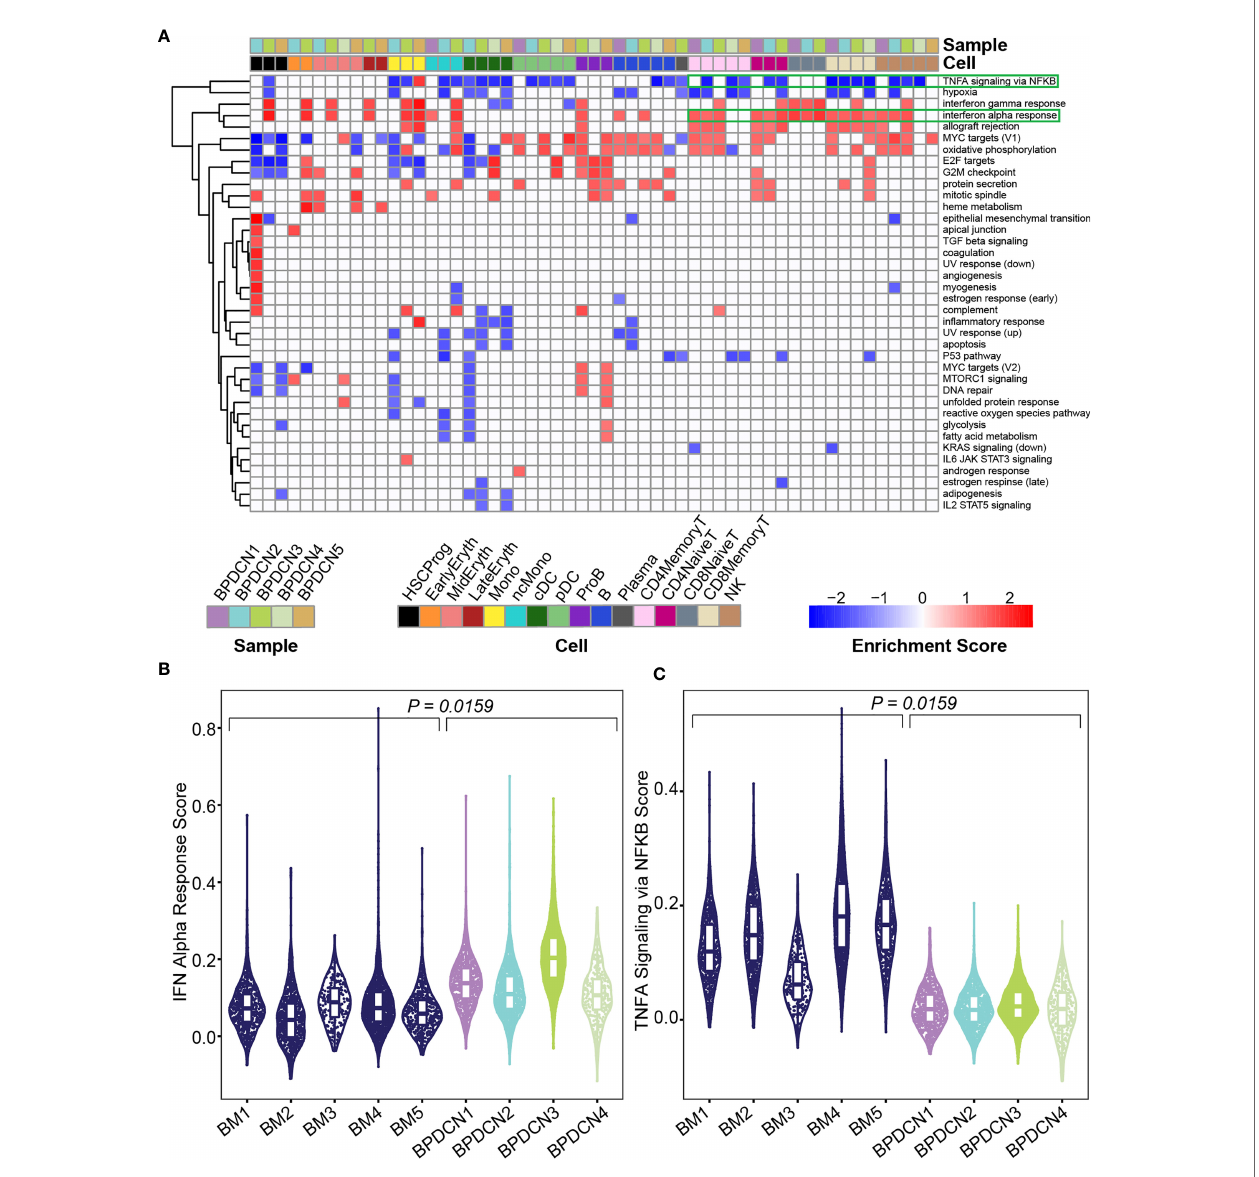
FIGURE 3 | Gene set enrichment shows enrichment of IFNA and depletion of TNFA related genes in BPDCN. (A) Heatmap shows Gene Set Enrichment Analysis normalized enrichment scores for each cell type and sample (columns) and signi fi cantly enriched Hallmark pathway (rows), determined by a P -value ≤ 0.05 in both GSEA tests. Red indicates high normalized enrichment scores and blue indicates low normalized enrichment scores. (B) Violin plot of IFN Alpha Response gene set scores (y-axis) for CD8+ Memory T-cells from each control and BPDCN sample (x-axis). Each dot within the violin plot represents a cell, with the box in the middle of the violin representing the median and interquartile range of the data. Healthy BM samples are colored in dark blue, BPDCN samples are colored using the sample color scheme from (A) . (C) Violin plot of TNFA Signaling via NFKB gene set scores (y-axis) for CD8+ Memory T-cells from each control and BPDCN sample (x-axis). P -values were calculated by comparing the medians of n = 5 healthy controls to n = 4 BPDCN